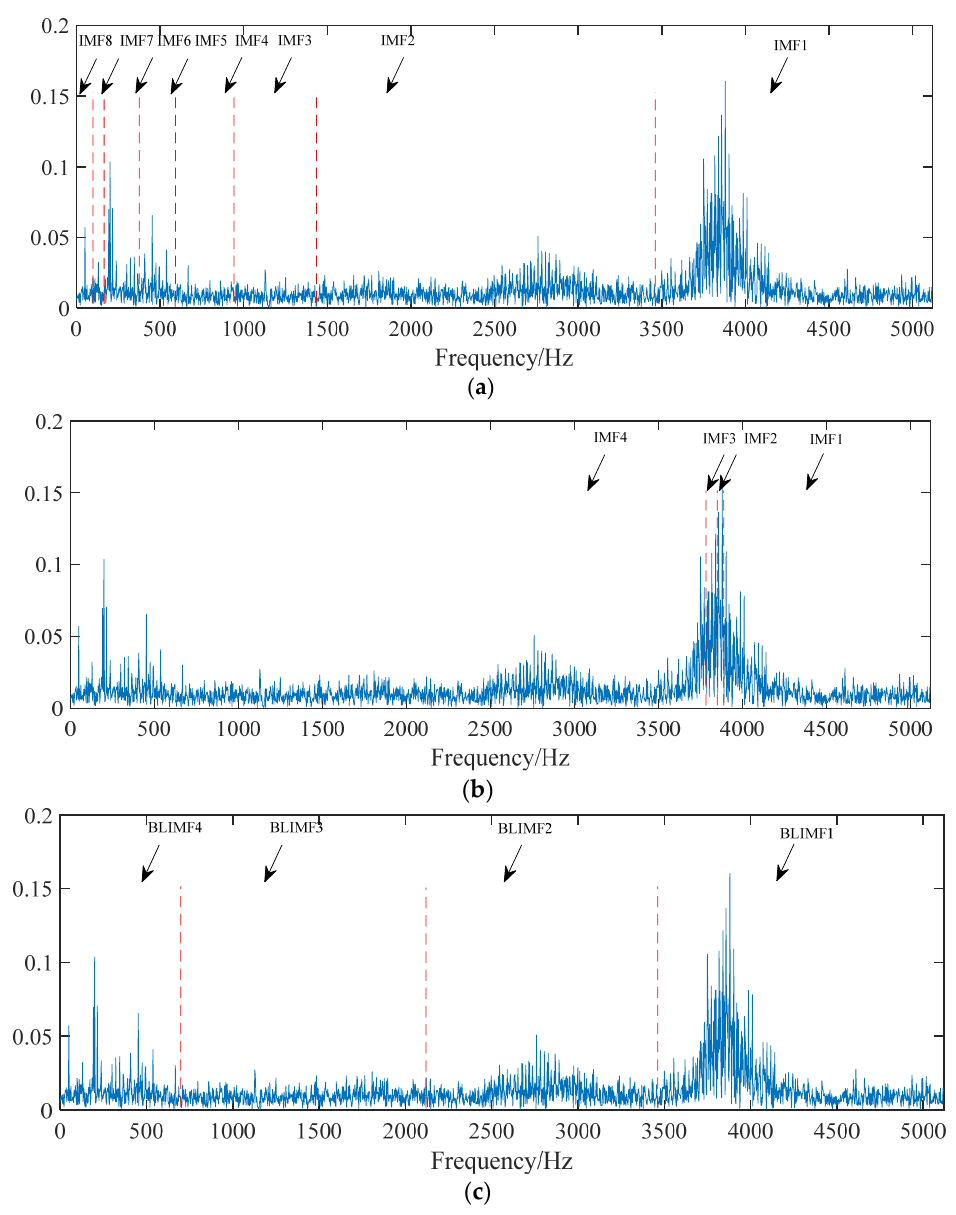
Figure 6. Decomposition results of the three algorithms: ( a ) CEEMDAN, ( b ) EWT, and ( c ) VMD.